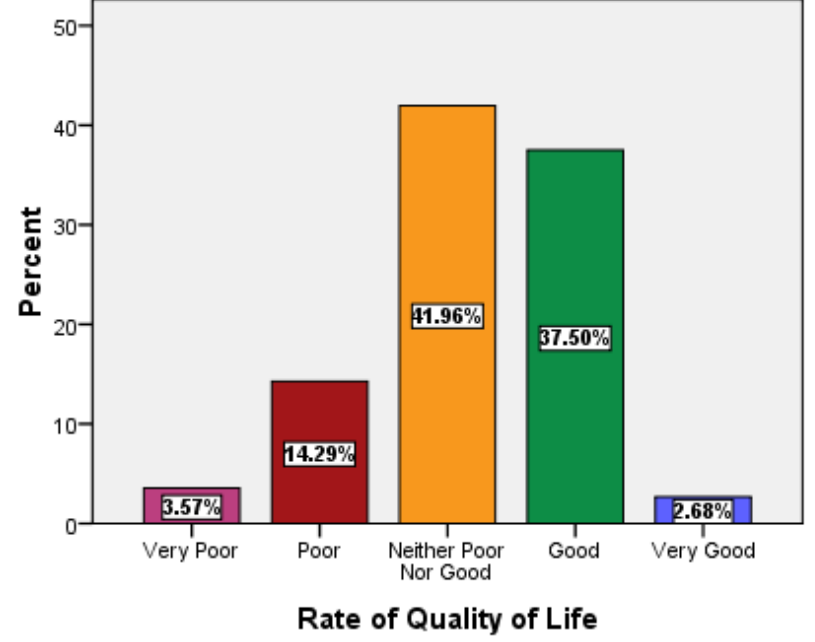
Figure 1. Descriptive statistics or characteristics of overall rate of QoL.